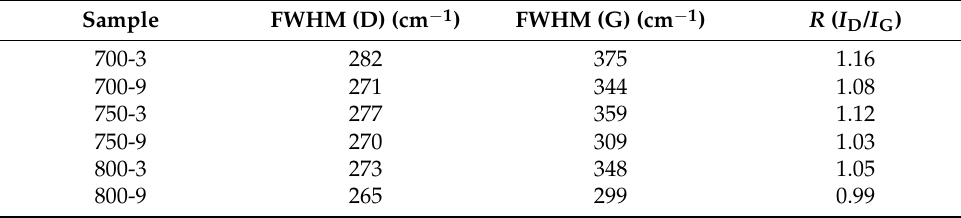
Figure 7. Raman spectra of the samples. Figure 8. The effect of graphite degree on resistivity.